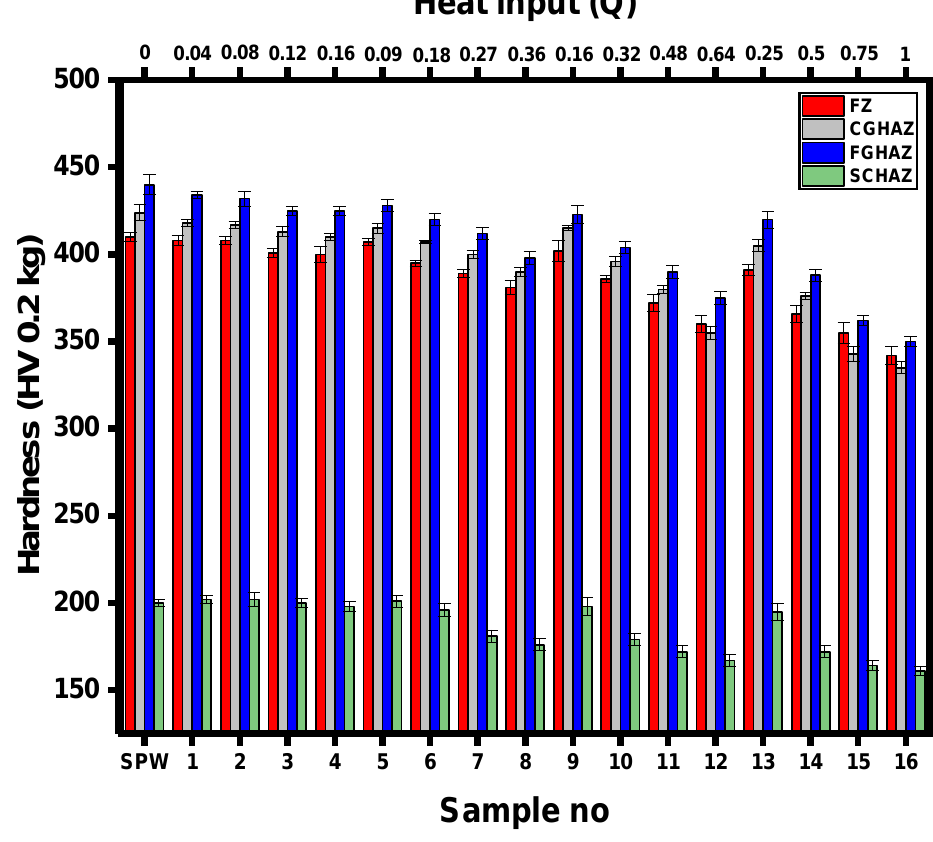
Figure 8. Average hardness profile of SPW and DPWs.